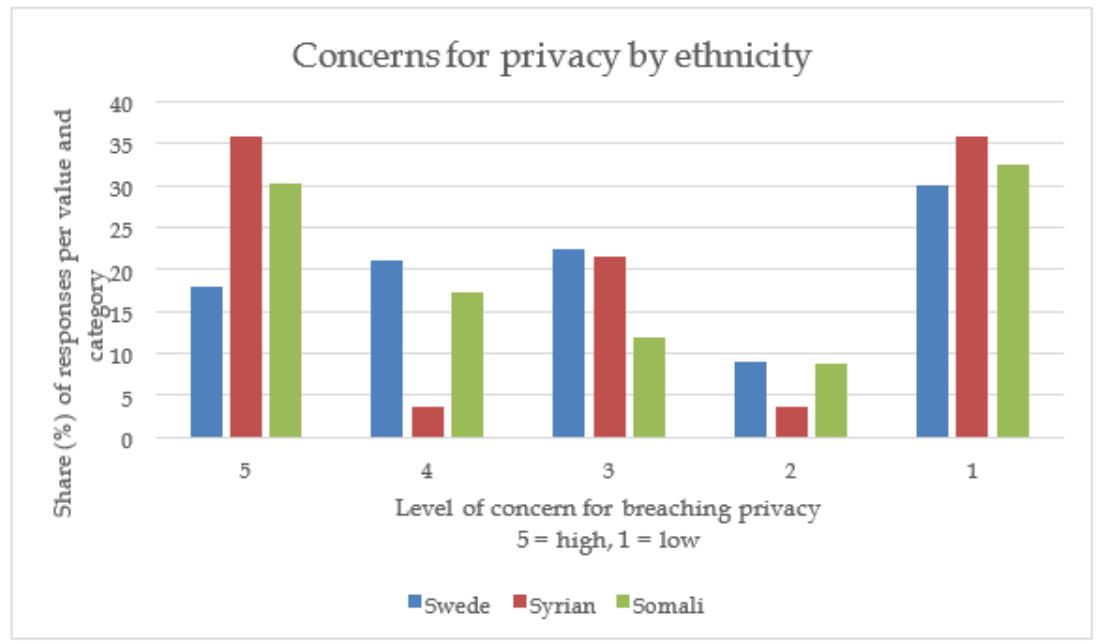
Figure 2. Concern about breaching privacy and ethnicity. Percentage per reported value on scale 5-1. Swedes n=67 (100%), Syrians n=28 (100%, Somalis n=93 (100%), Total n=188.